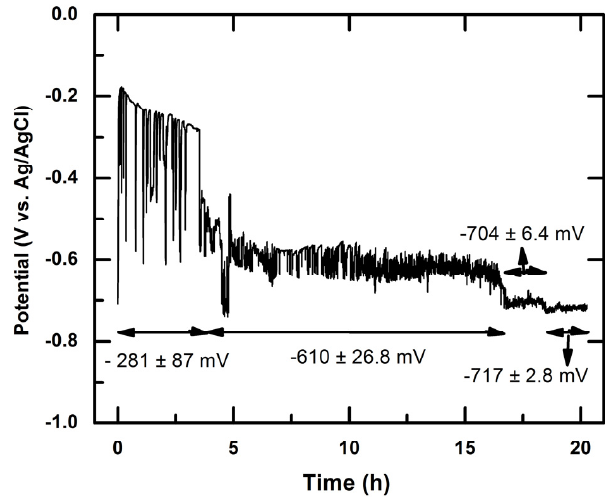
Figure 3. The variation of open circuit potential (OCP) with time on the superhydrophobic AAO (SHAAO) surface.